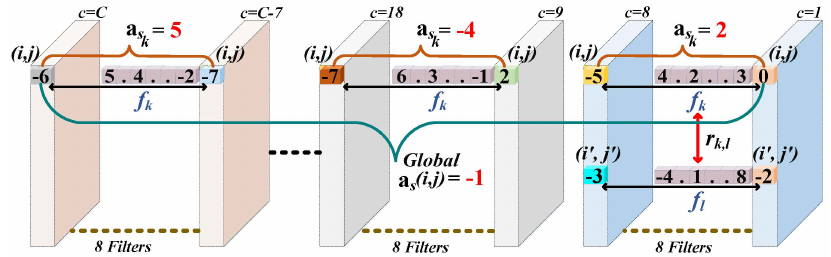
Figure 7. Novel Spatial Attention Learning for Individual